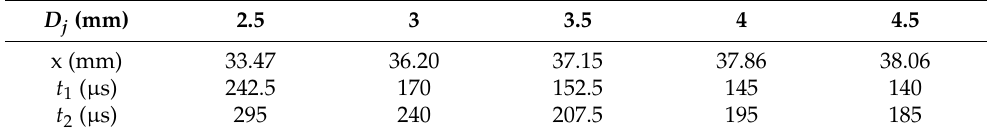
Table 5. Abscissa of the Mach stems and critical moments t 1 and t 2 in initiation under different jet